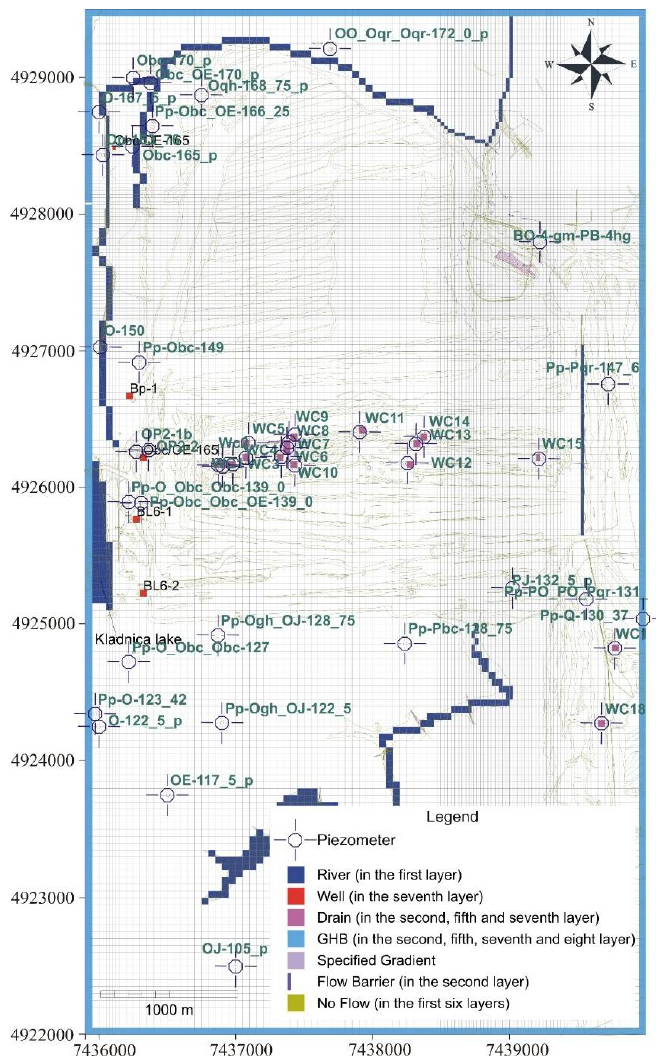
Figure 9. Discretization of the extended area of the open-pit mine Tamnava–West Field, including boundary conditions.